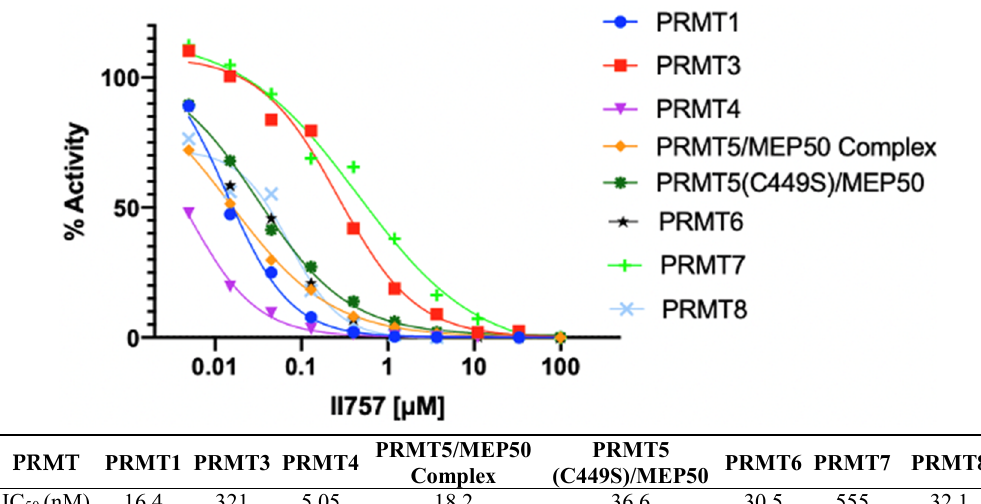
Figure 6. Selectivity of II757 against the panel of PRMTs. II757 was tested in 10 doses with threefold serial dilution in the HotSpot methyltransferase assay at reaction biology.